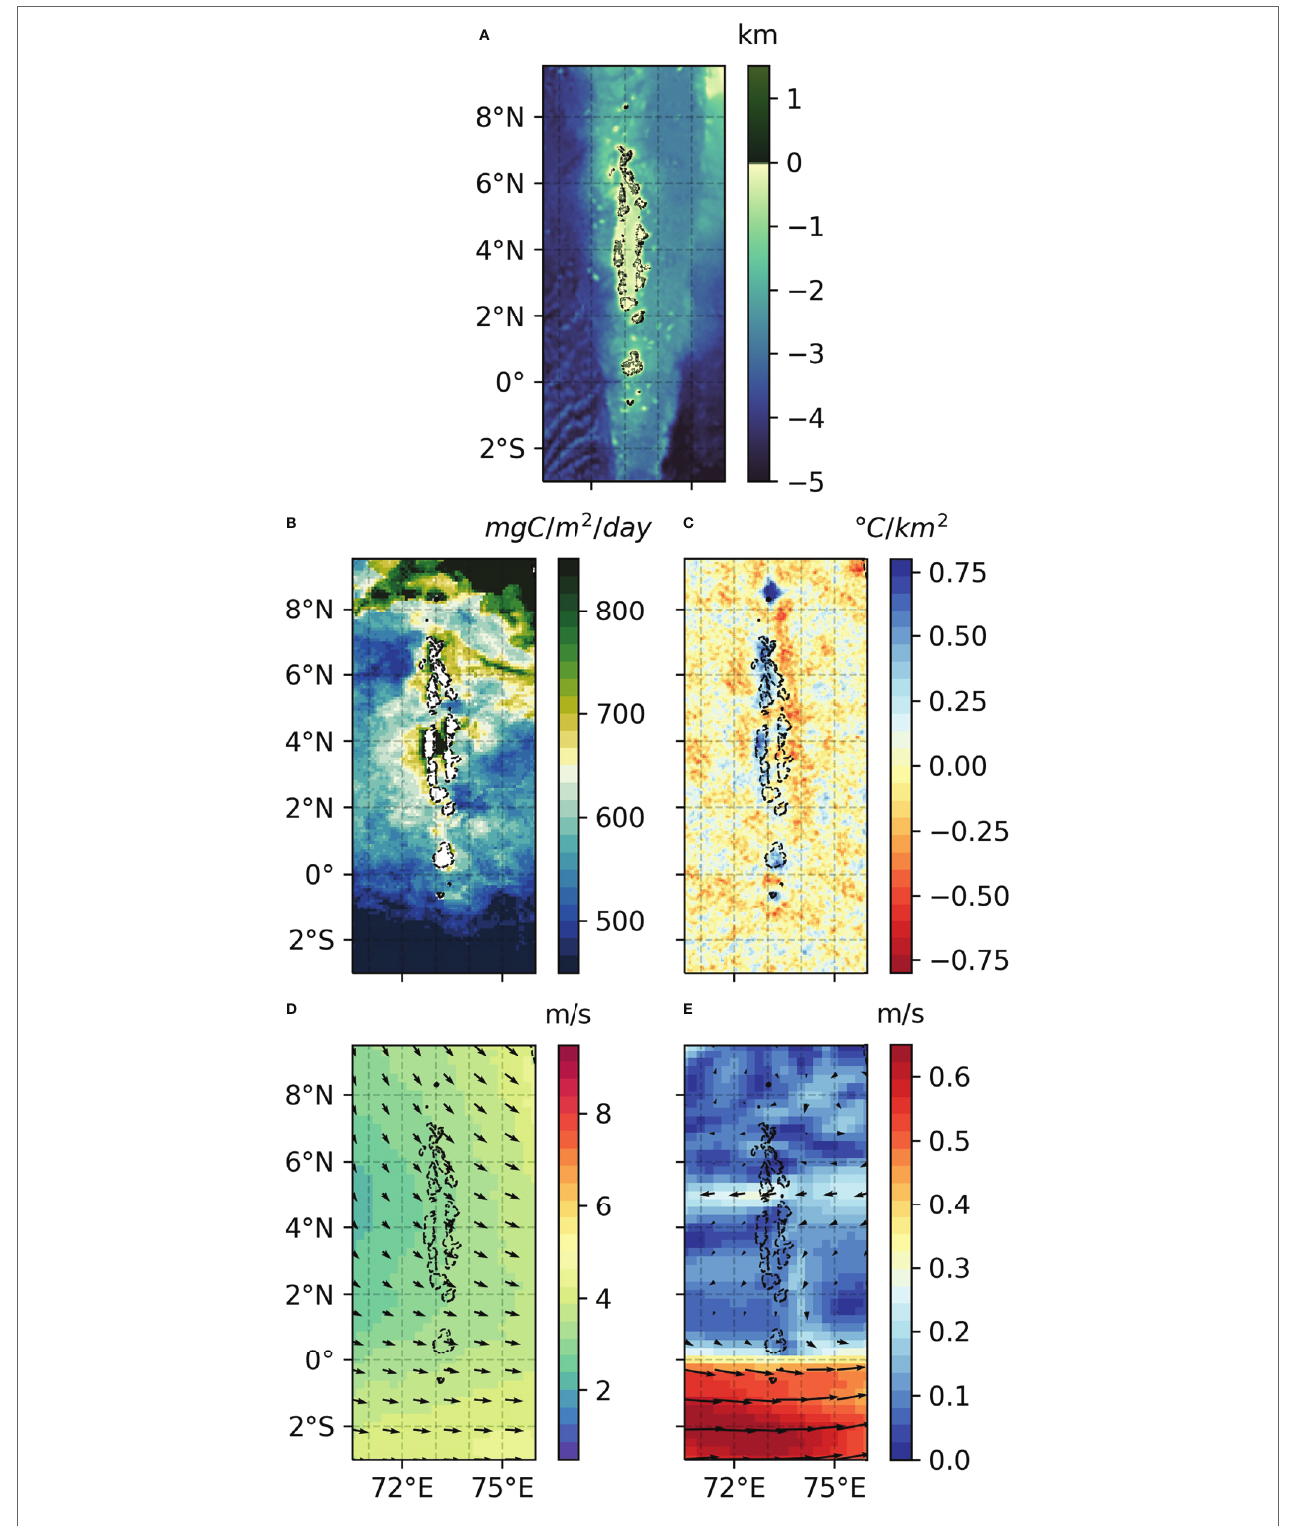
FIGURE 11 | Maldives (A) Topography, (B) NPP, (C) SST Laplacian, (D) Wind Speed, (E) SODA3 currents, April 2013. Black dashed line represents the 100 m depth